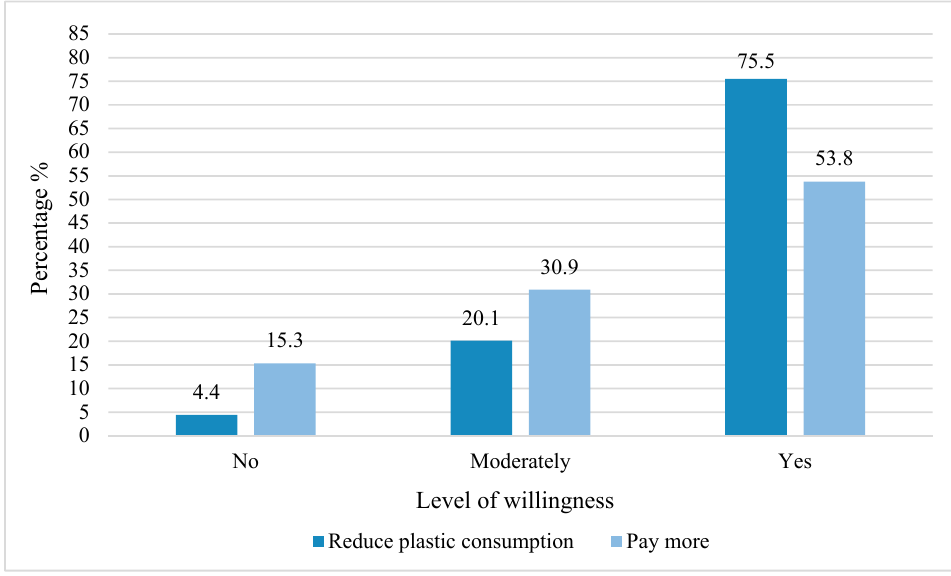
Figure 7. Willingness to reduce plastic consumption or to pay more for alternatives.